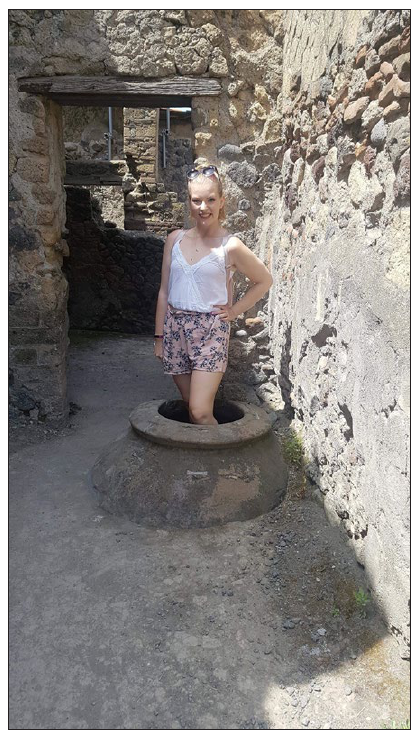
Figure 3: Recently graduated IoA student Rosalyn Christian exploring Herculaneum (Photo Rosalyn